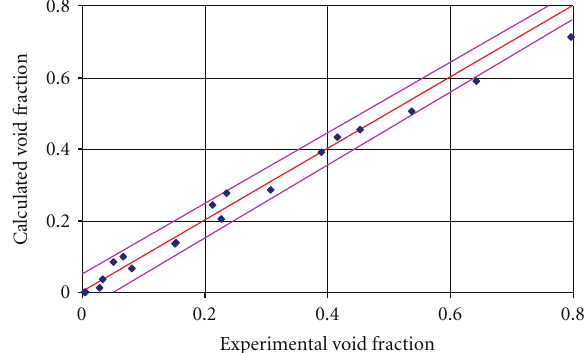
Figure 4: Comparison between calculated and measured void frac- tion for subchannel type